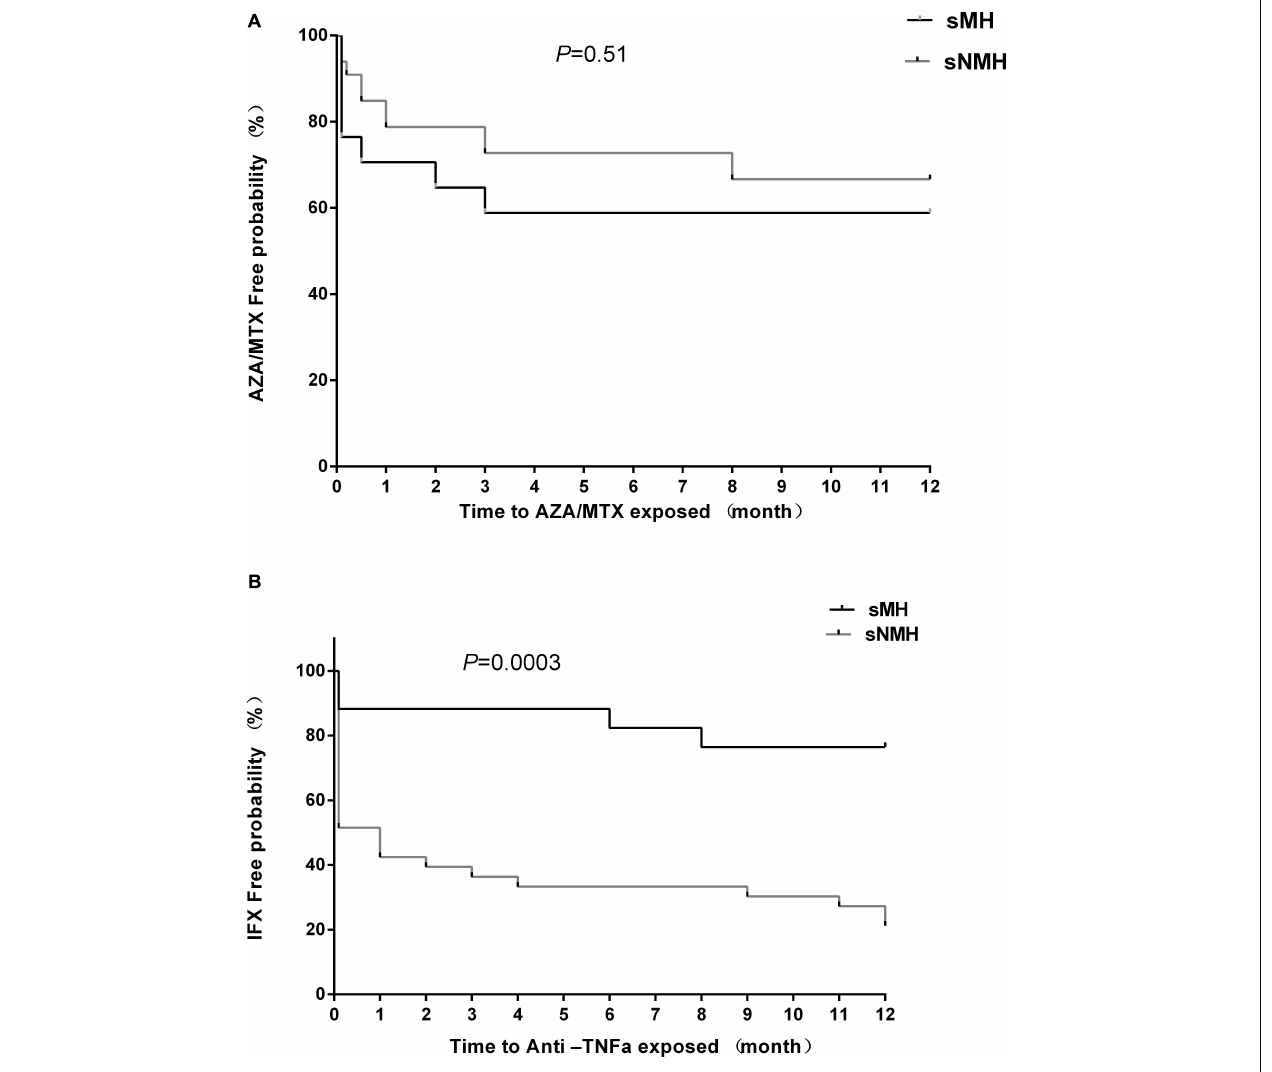
FIGURE 3 | Kaplan–Meier curve depicting the difference in the AZA/MTX-free (A) and infliximab-free (B) probability between the sMH and sNMH groups after EEN induction. Abbreviations: sMH, sustained mucosal healing; sNMH, sustained non-mucosal healing; AZA, azathioprine; MTX, methotrexate; IFX,